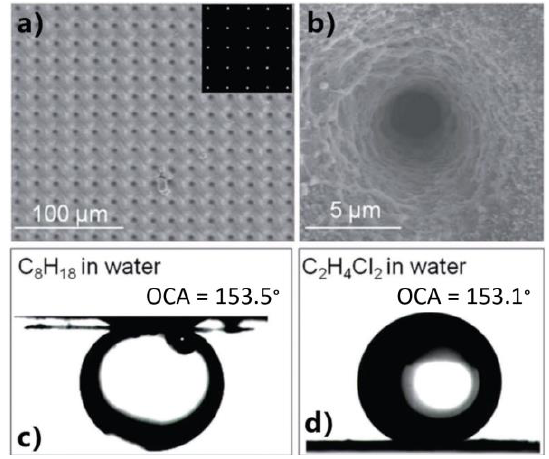
Figure 11. ( a ) SEM image of the micropores drilled in ultrathin aluminum foil by FS laser ablation; the inset shows that light can pass through the micropores’ array. ( b ) Magnified image of the treated foil showing that the rim of the pores is decorated with microstructures; ( c ) underwater contact angle of a light oil (C 8 H 18 ) droplet on the laser-treated aluminum foil; and ( d ) underwater contact angle of a heavy oil (C 2 H 4 C l2 ) droplet on the laser-treated aluminum foil [70]. OCA: oil contact angle. Reproduced with permission from [70] Royal Society of Chemistry 2016.